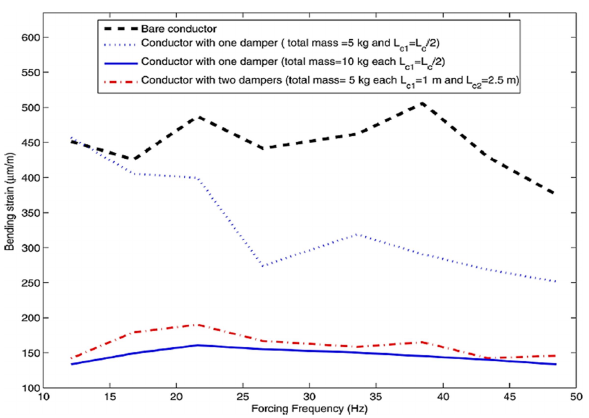
Figure 8: Meandering strain of a characteristic extent length of transmission